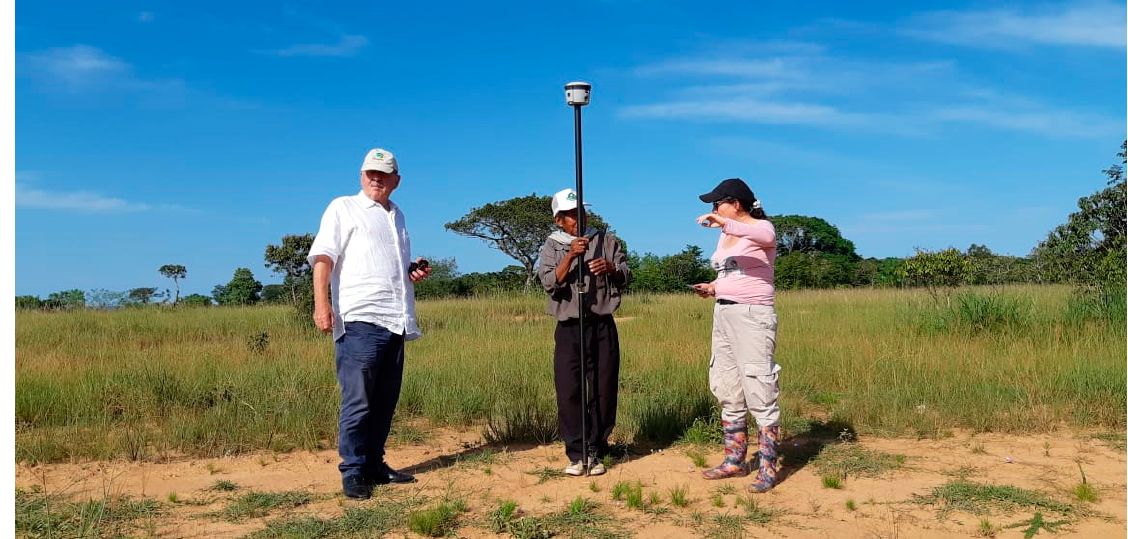
Figure 4. Measuring the boundary of the Santa Teresita del Tuparro reserve with Indigenous leader Horacio Bonilla using a Global Network Satellite Systems (GNSS) antenna. Cumaribo, 2019. Source: Land in Peace Project, Kadaster.